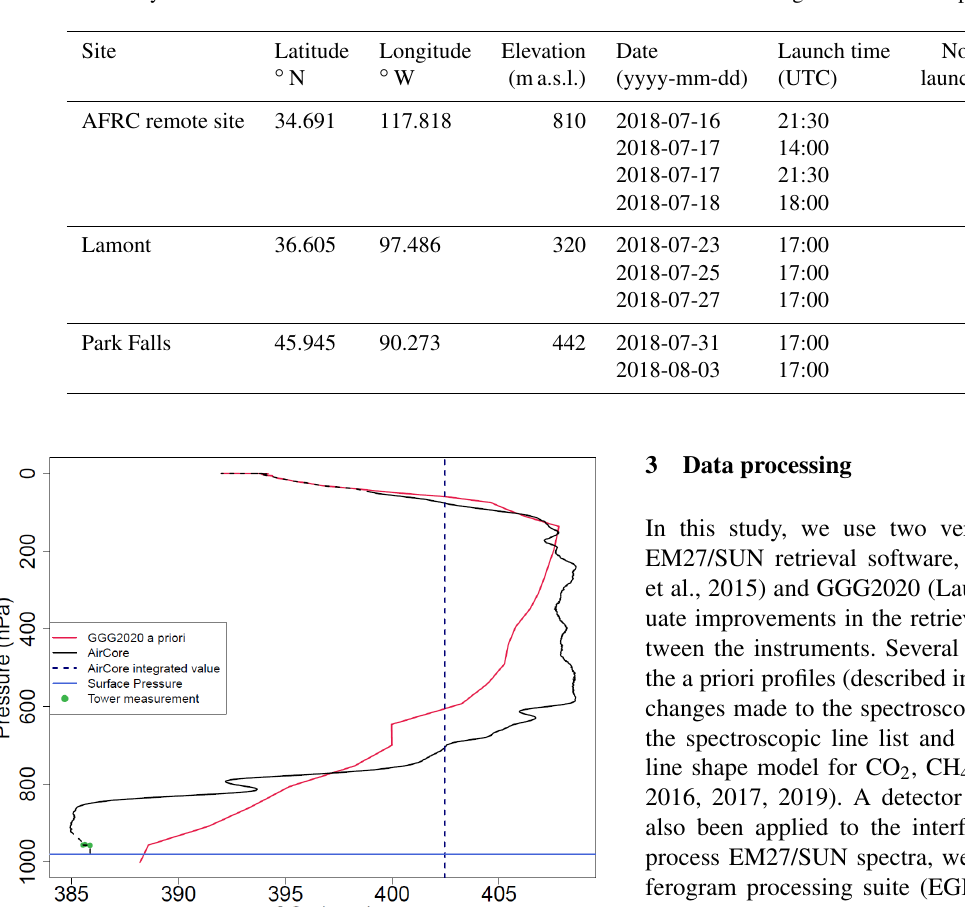
Table 2. Summary of AirCore launches coincident with EM27/SUN measurements during the 2018 road trip.